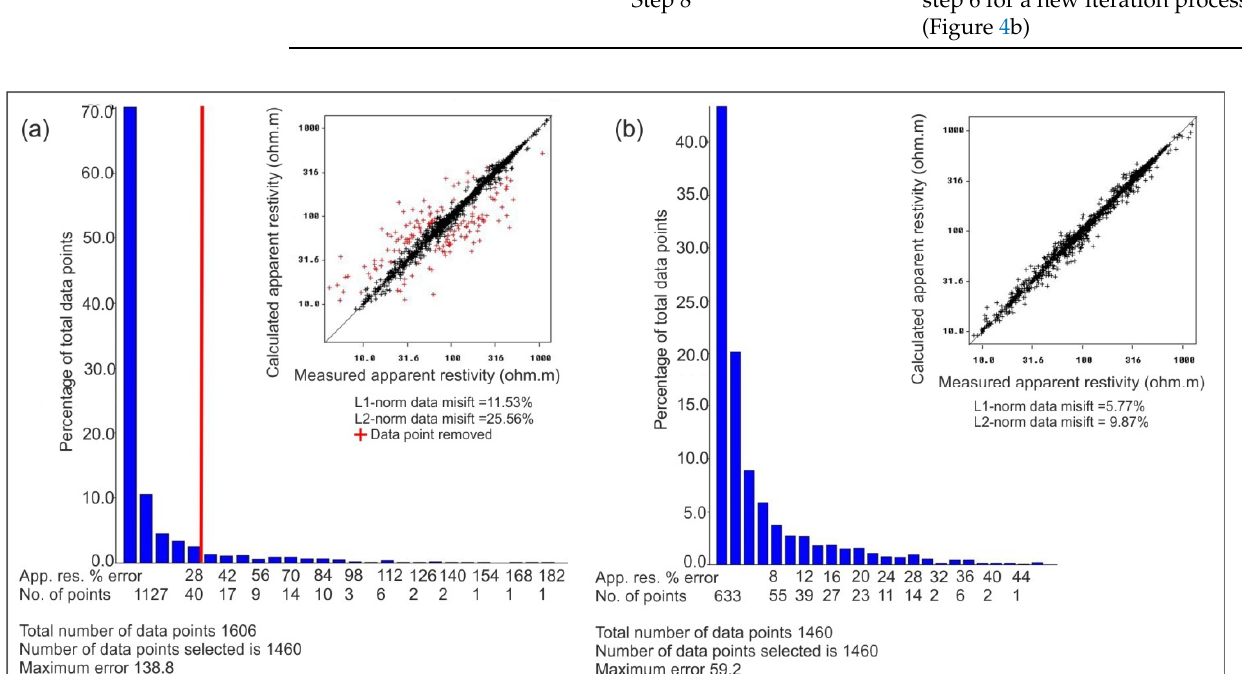
Figure 4. ( a ) Error distribution after 9 iterations (absolute error = 11.53) between calculated and measured resistivities for the La Torrecilla ERT survey in first inversion. ( b ) Error distribution after five iterations (absolute error = 5.8) between calculated and measured resistivities in second inversion, once the points that exceeded 25% misfit (red crosses) were removed.